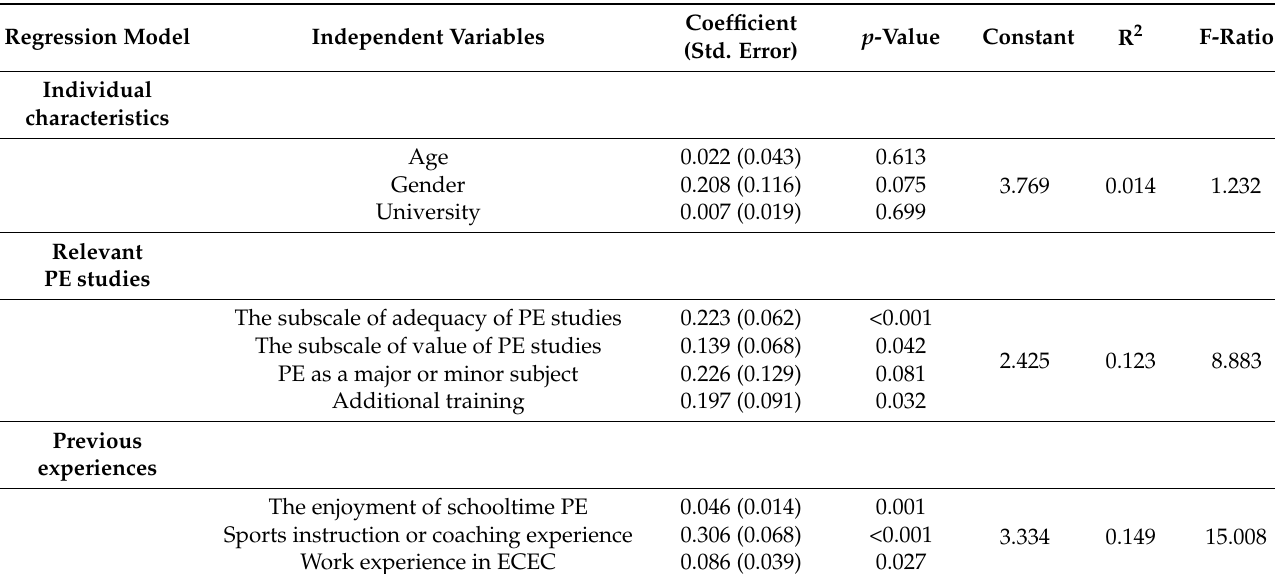
Table 3. Linear regression results for supporting a child’s